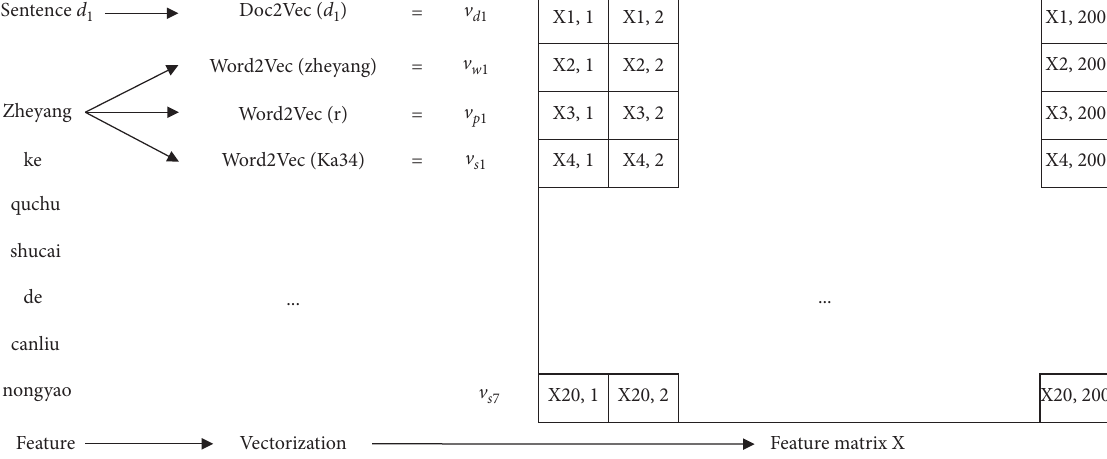
Figure 3: The process of constructing the feature